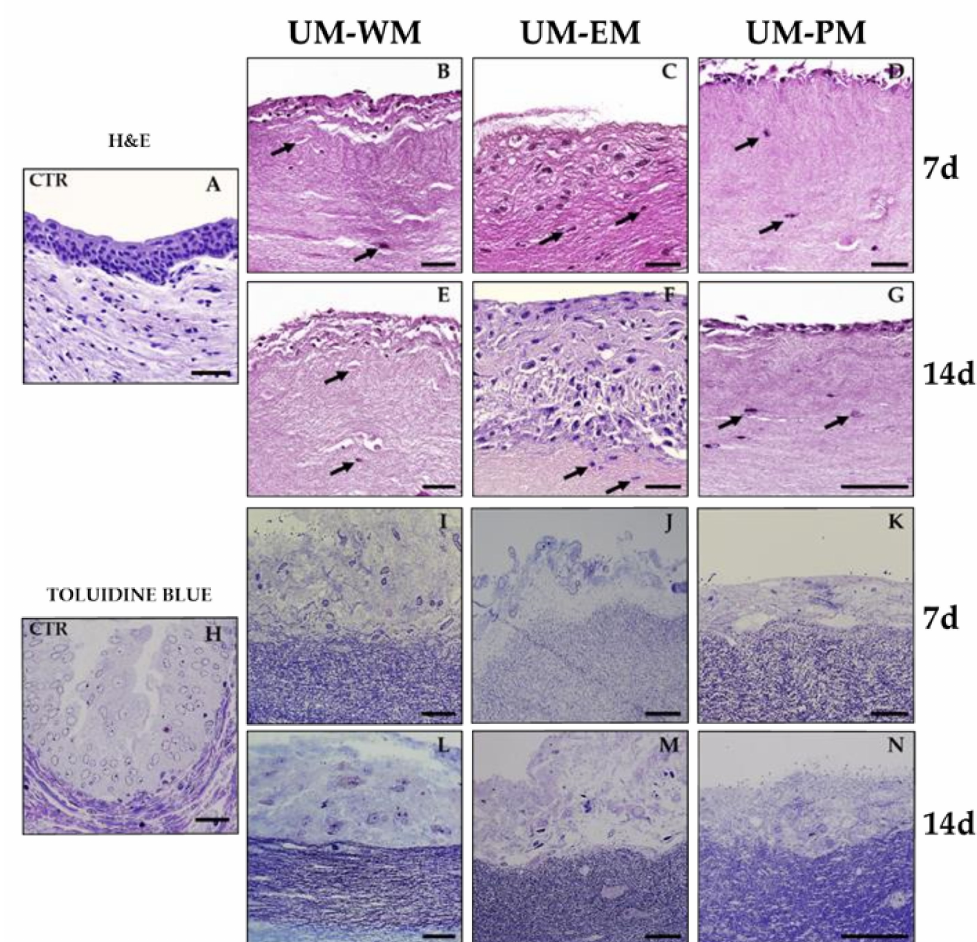
Figure 2. Histological analysis of control human UM (CTR) and tubularized heterotypical substi-tutes of the human UM cultured with three different media (WM, EM, and PM) for 7 and 14 days and stained with hematoxylin-eosin ( A – G ) and semithin sections with toluidine blue ( H – N ). Illustrative cells have been highlighted with arrows in the stroma of bioartificial UM tissues stained with hematoxylin-eosin. Scale bars: 50 µ